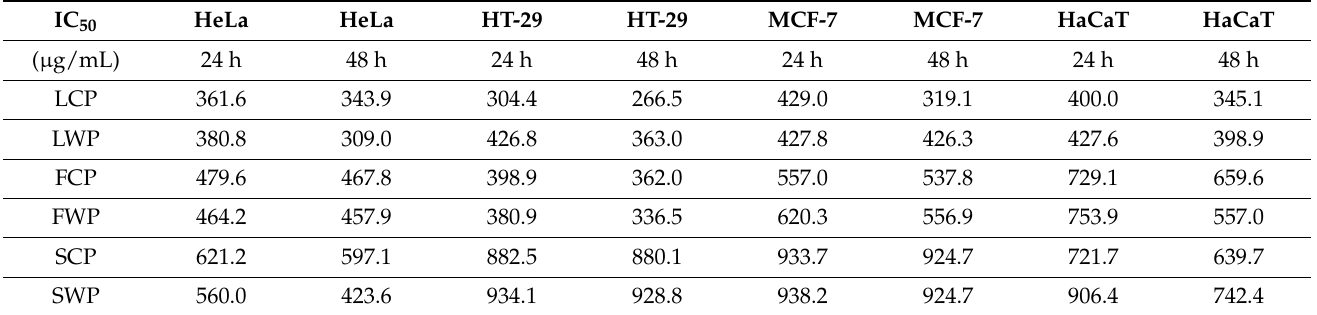
Table 4. Half-maximal inhibitory concentrations (IC 50 ) of extracts from in vitro cultivated and wild-growing C. vulgare .